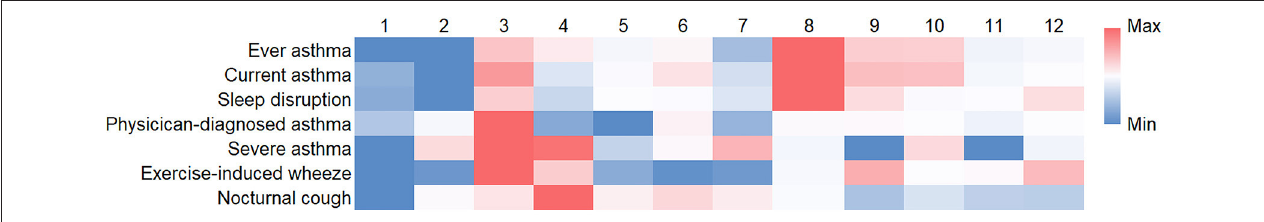
FIGURE 1 | The prevalence of asthma symptoms stratified by community. The heatmap displays the differential prevalence of asthma symptoms across the communities. Blue represents low value, and red represents high value. (1) Daqiao community, (2) Dinghai community, (3) Jiangpu community, (4) Kongjiang community, (5) Pingliang community, (6) Siping community, (7) Wujiaochang community, (8) Xinjiangwan community, (9) Yanji community, (10) Yinhang community, (11) Changbai community, and (12) Changhai community.